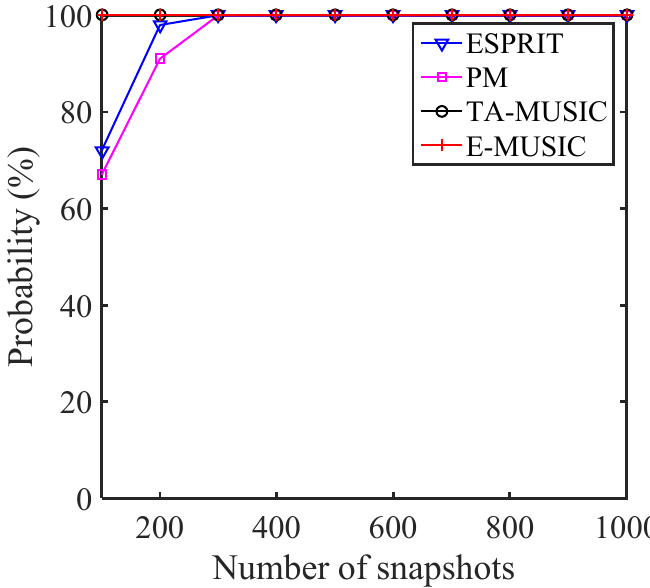
Figure 12. Resolution against number of snapshots for various algorithms.